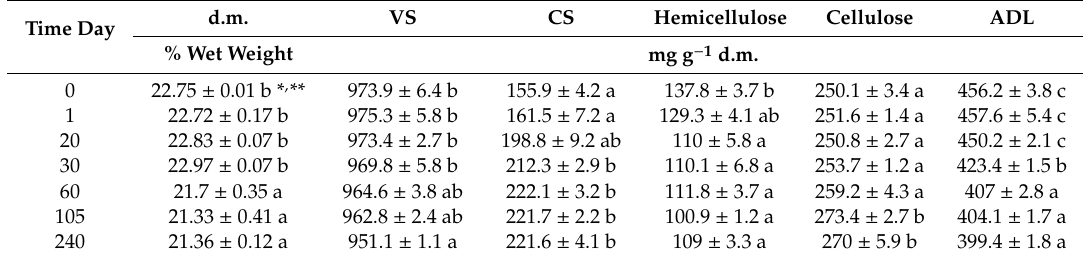
Table 1. Tomato pomace (TP) macromolecular composition and evolution during fermentation. d.m. VS CS Hemicellulose Cellulose ADL Time Day